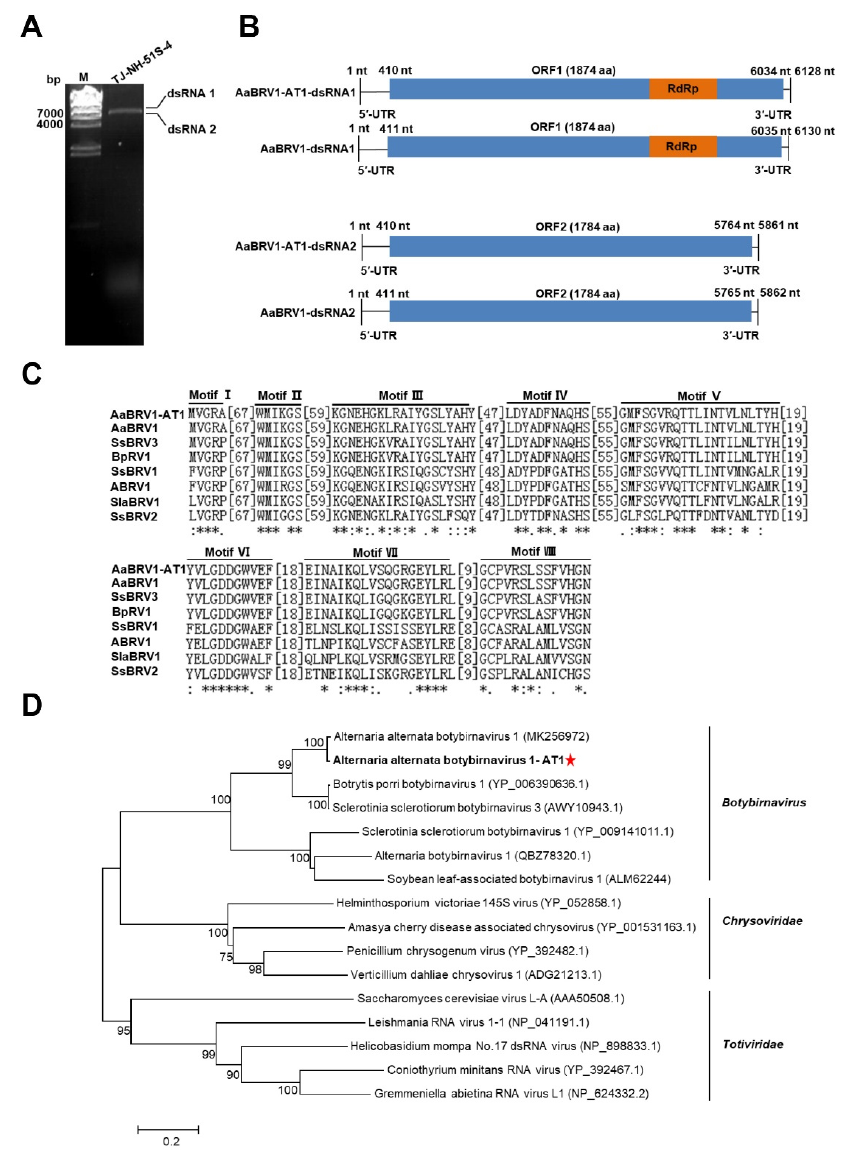
Figure 1. Characterization of the mycovirus Alternaria alternata botybirnavirus 1-AT1 (AaBRV1-AT1) in Alternaria tenuissima strain TJ-NH-51S-4. ( A ) Gel electrophoretic profiles of double-stranded RNA (dsRNA) extracted from strain TJ-NH-51S-4, which was treated with DNase I and S1 Nuclease (M: λ - Hin d III digest DNA marker). ( B ) Schematic diagram of the genomic organization of AaBRV1-AT1 and Alternaria alternata botybirnavirus 1 (AaBRV1). Open reading frames (ORFs) and untranslated regions (UTRs) are indicated by rectangles and single lines, respectively. The orange bar indicates conserved domains of RNA-dependent RNA polymerase (RdRp). ( C ) Multiple alignments of amino acid (aa) sequences of the RdRps in AaBRV1-AT1 and representative members of the genus Botybirnavirus . Eight conserved motifs (motif I to motif VIII) were identified in AaBRV1-AT1 and other members of the genus Botybirnavirus . Asterisks represent identical amino acid residues, colons represent amino acids with a high level of chemical similarity, and dots represent amino acid residues with a low of chemical similarity. ( D ) Phylogenetic tree based on the deduced aa sequences of the putative RdRps in AaBRV1-AT1 and other members of the genus Botybirnavirus using the maximum-likelihood (ML) method with 1000 bootstrap replicates. Bar scale represents a genetic distance of 0.2 aa substitutions per site. Red star indicates the position of